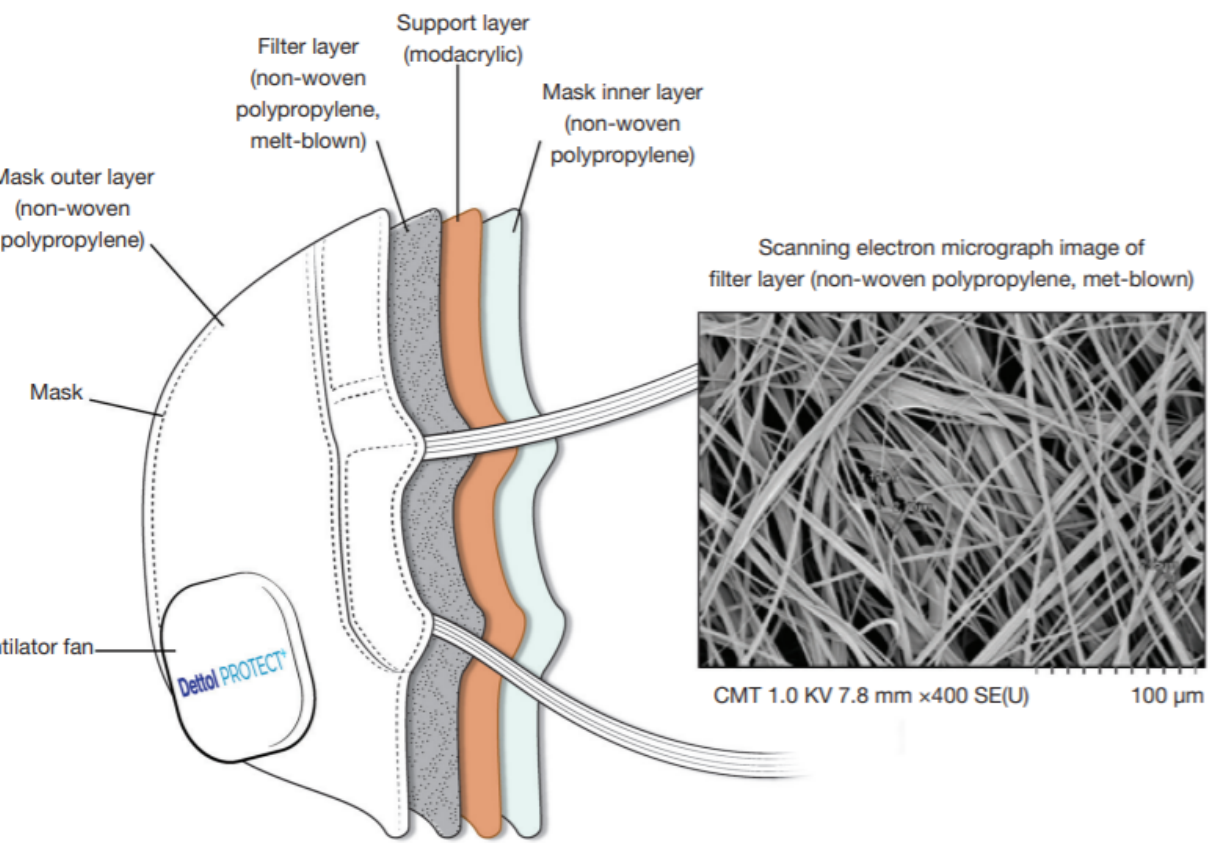
Figure 5. Three types of phase inversion: ( a ) dry-jet wet spinning, ( b ) non-solvent-induced phase separation, and ( c ) electrospinning [86].